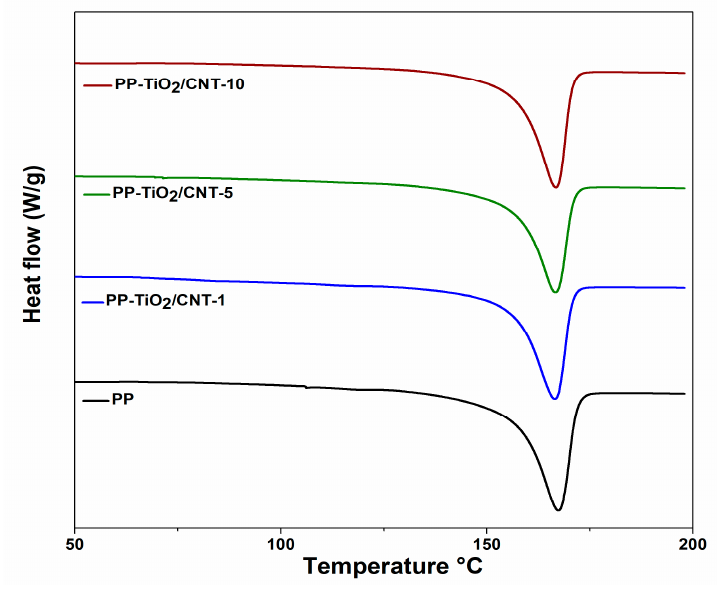
Figure 6. Differential scanning calorimetry (DSC) fusion endotherms of pure polypropylene (PP) and PP-TiO 2 /CNT (carbon nanotubes) (1, 5, 10%).